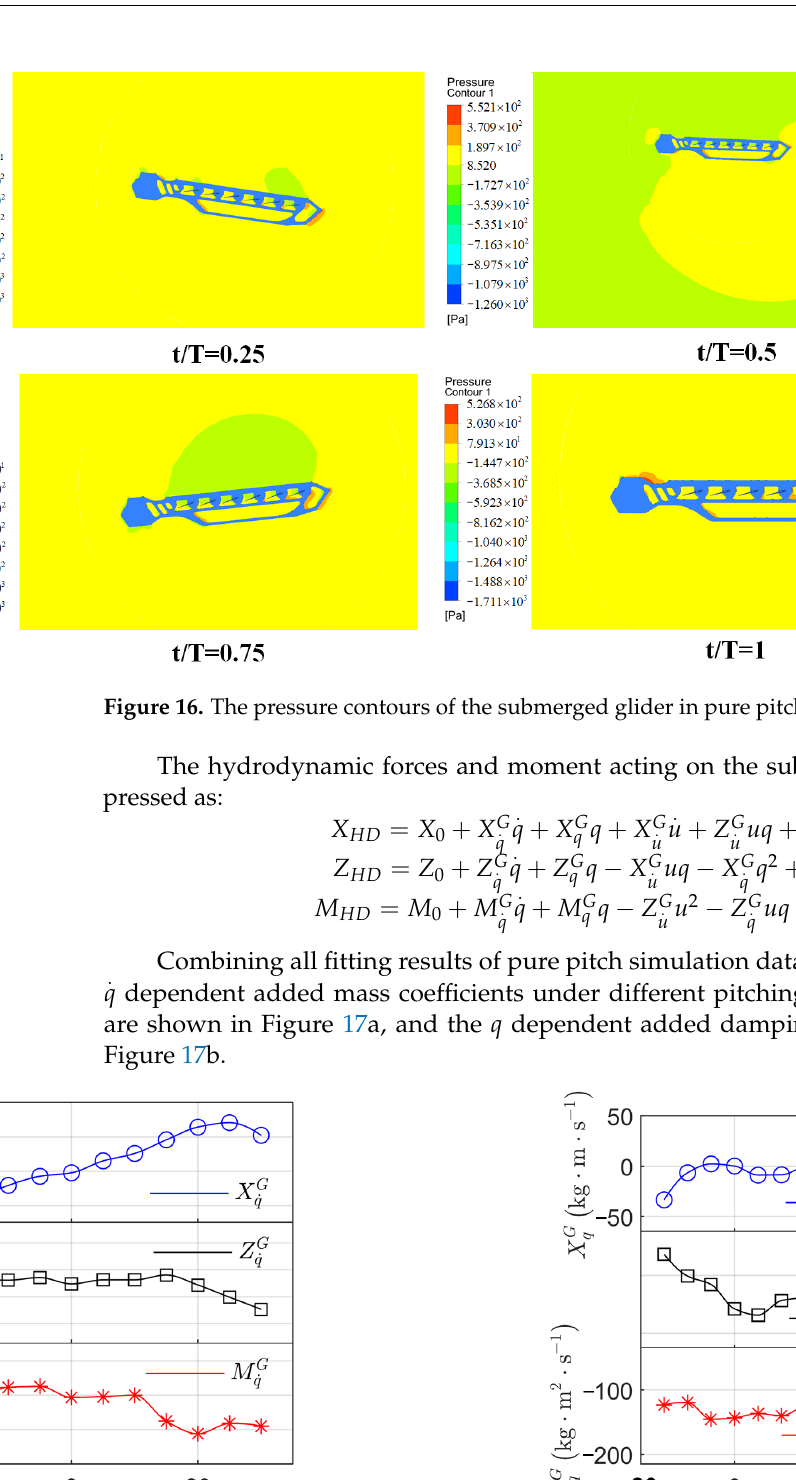
Figure 17. The results of pure pitch simulation: ( a ) the results of q dependent added mass coefficients; ( b ) the results of q dependent added damping coefficients.